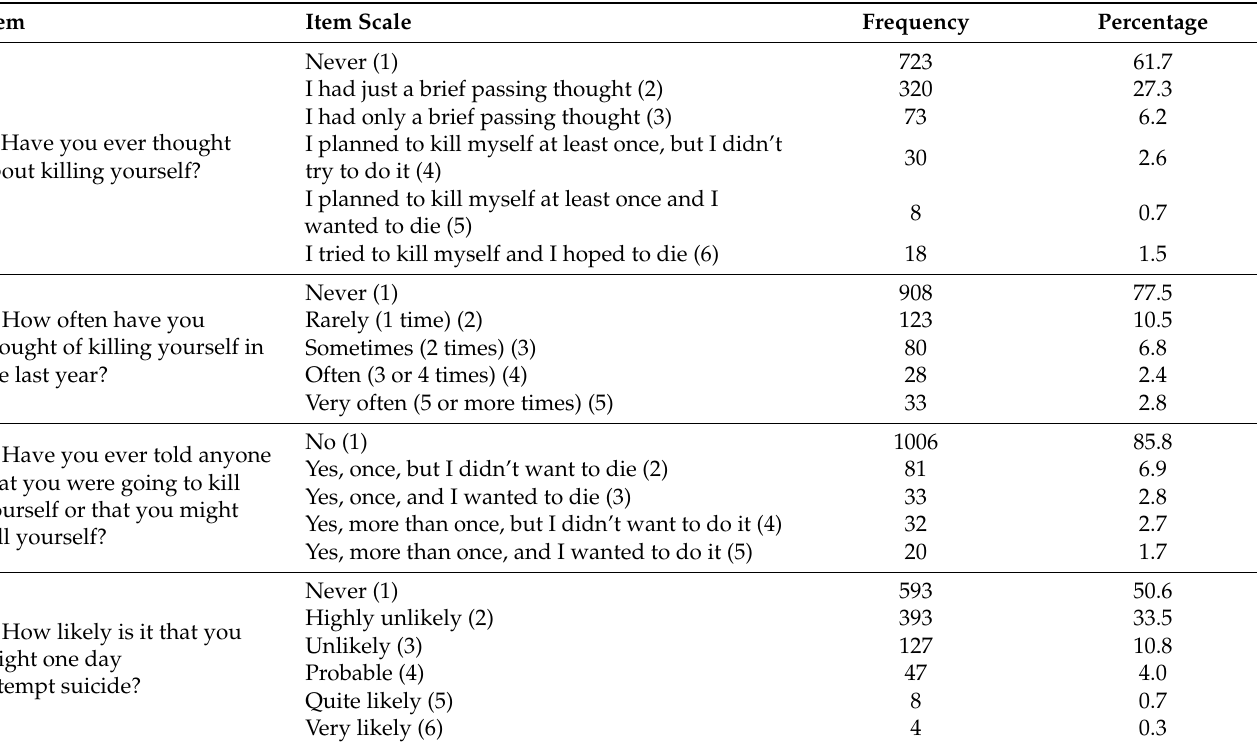
Table 1. Descriptive statistics of each of the items of the suicidal behaviours